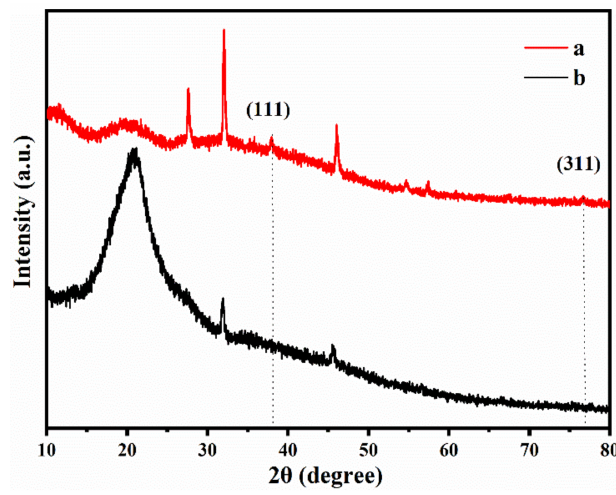
Figure 2. XRD spectra of the MC/Ag NPs film ( a ) and pure MC ( b ).